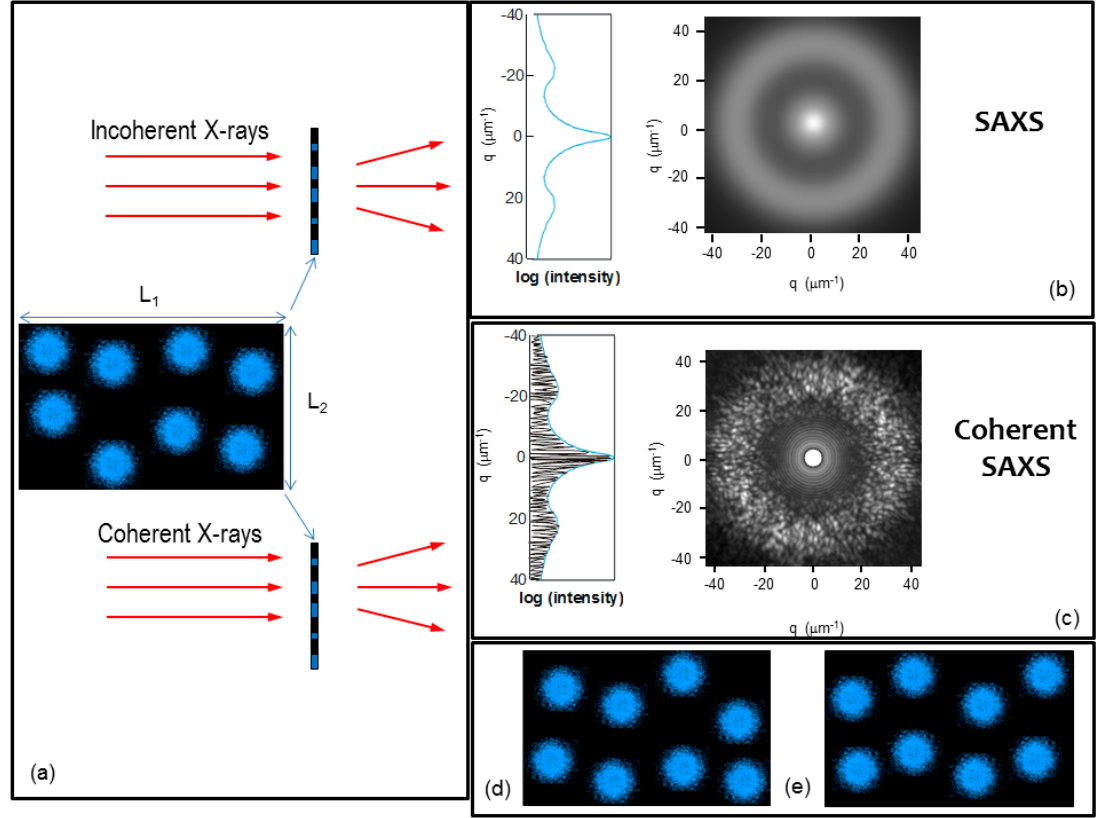
Figure 10. ( a ) non-periodic array of nano-objects, random spheres, in a L 1 × L 2 area; ( b ) schematic 2D and 1D (blue line) SAXS pattern, if incoherent X-rays are used to illuminate the sample in (a); ( c ) schematic 2D and 1D (blue line) SAXS speckled pattern, if coherent X-rays are used to illuminate the sample in (a); ( d , e ) same nano-objects as in (a), located in different positions.